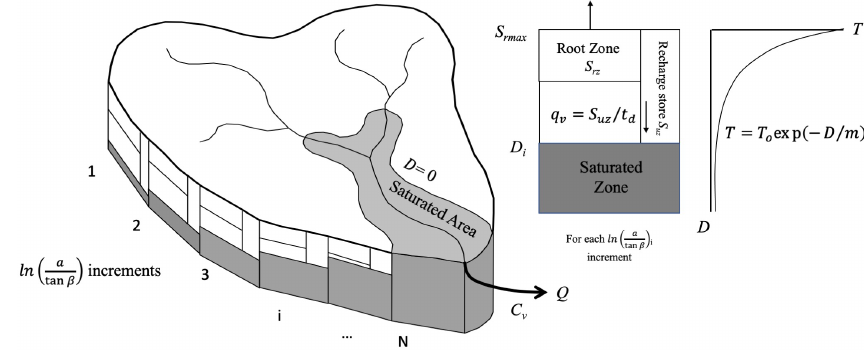
Figure 3. Schematic of the classical version of TOPMODEL (see Table 1 for the definition of the